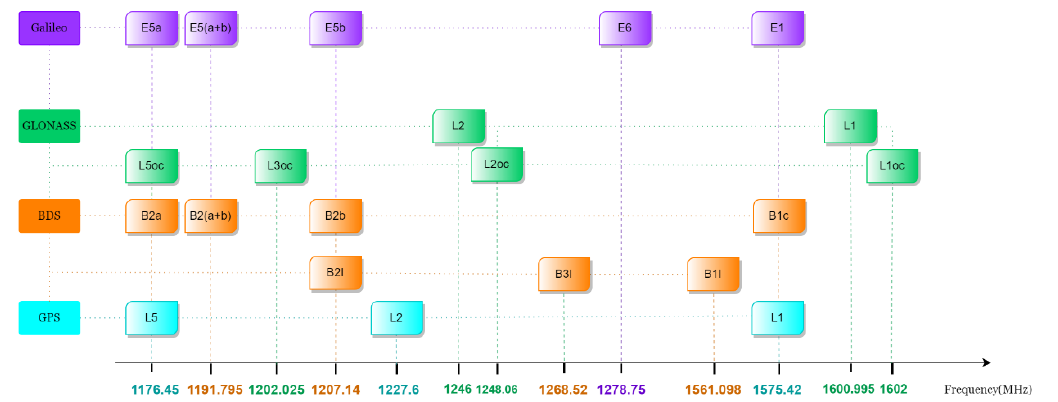
Figure 1. Frequency distribution of GNSSs.